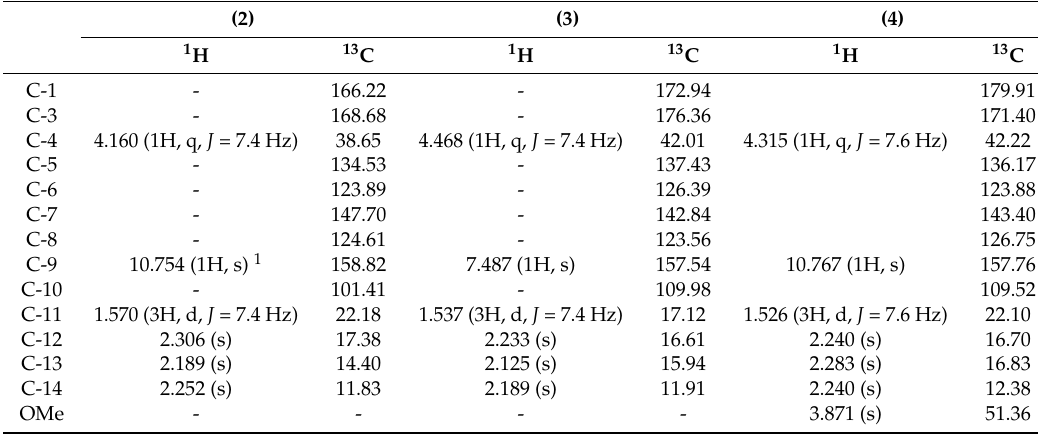
Table 1. NMR data of compounds ( 2 )–( 4